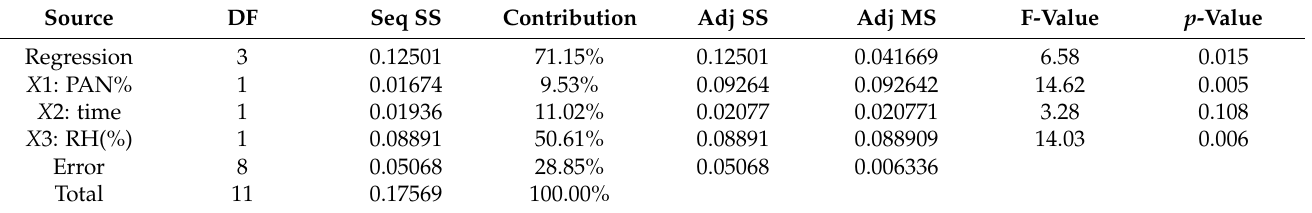
Table 4. The ANOVA for the model of output variable Y 1 in coded variables containing only main